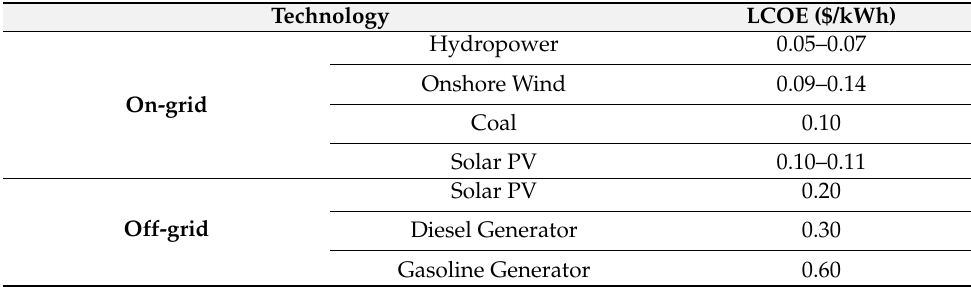
Table 10. Grid and off-grid electricity LCOE costs, 2017. Data taken from